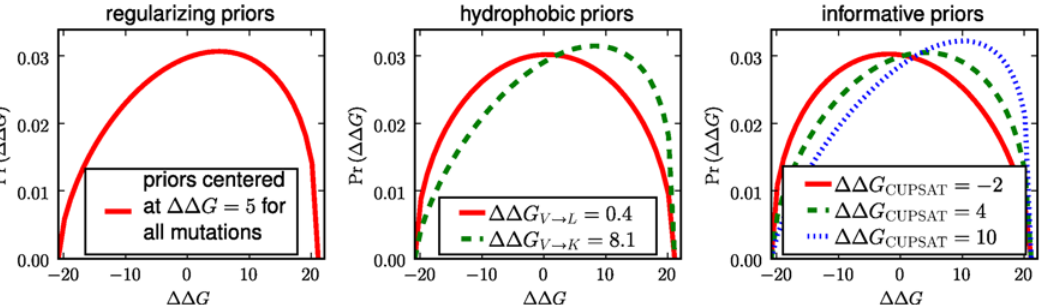
Figure 4. Prior distributions, Pr DD G